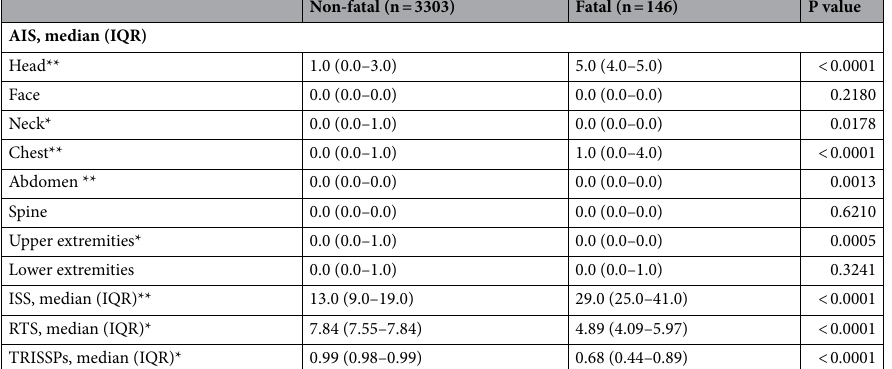
Table 2. AIS score by body region, ISS, RTS, and TRISSPS score in adults (26–45 years) in the fatal and non- fatal groups (2004–2019). AIS abbreviated injury scale, ISS injury severity score, IQR interquartile range, RTS revised trauma scale, TRISSPS trauma and injury severity score probability of survival. *The median value in the non-fatal group was significantly higher than that in the fatal group. **The median value in the non-fatal group was significantly lower than that in the fatal group. Student’s t-test was used for values with a normal distribution, while the Wilcoxon test was used for values with a non-normal distribution.